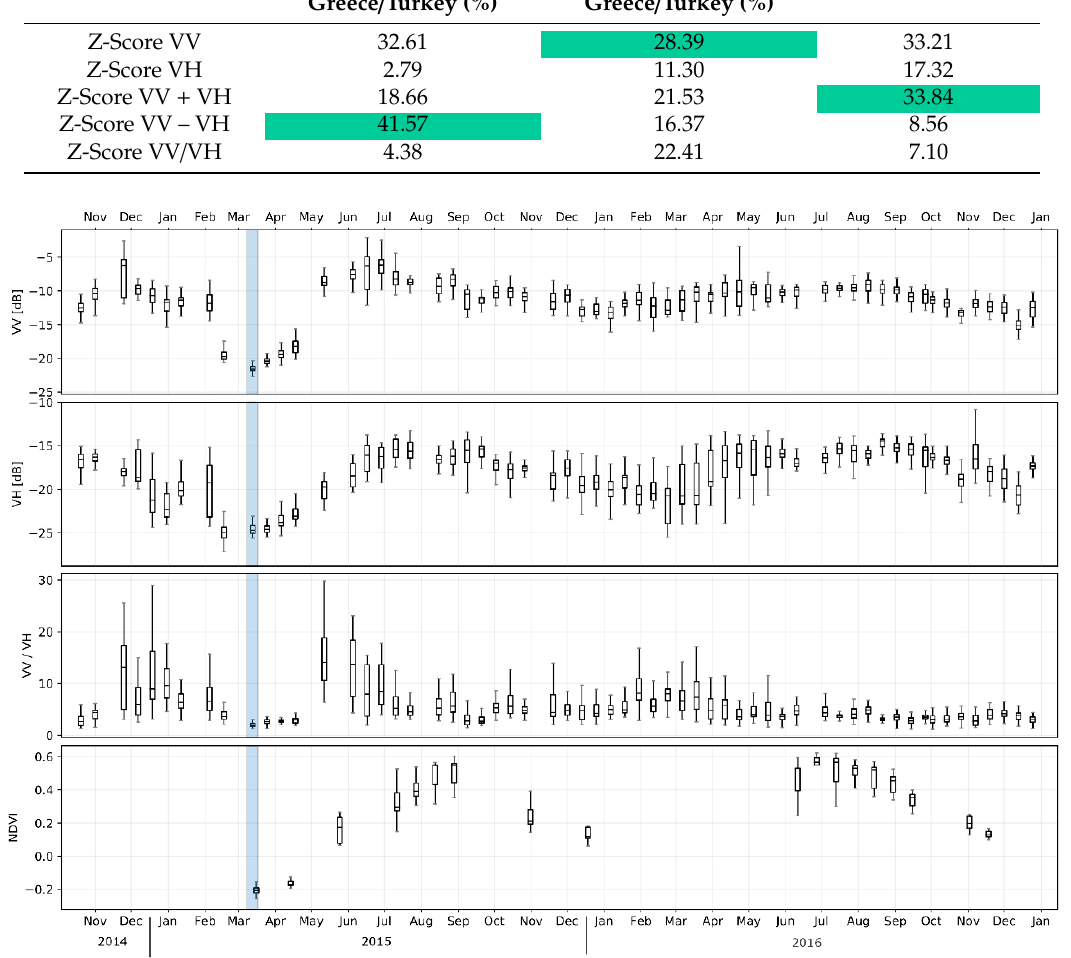
Figure 6. Multitemporal behavior of the backscatter intensity for TOW areas for VV (decibel (dB)), VH (dB), VV/VH (linear scale), and Normalized Difference Vegetation Index (NDVI) values in northern Greece/Turkey. The blue bars mark the analyzed date at the flood event. Table 4. Random forest importance analysis of the time series features for TOW and individual study areas. The rows highlighted in blue represent the time series features with the highest contribution (importance).